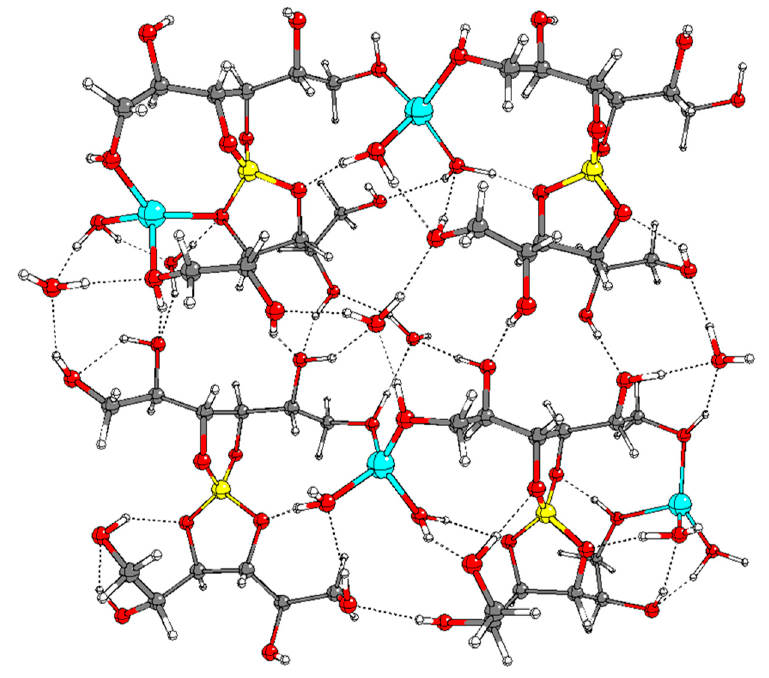
Figure 2. Fragment of the crystal structure of LiM 2 B optimized at the B3LYP level of theory.